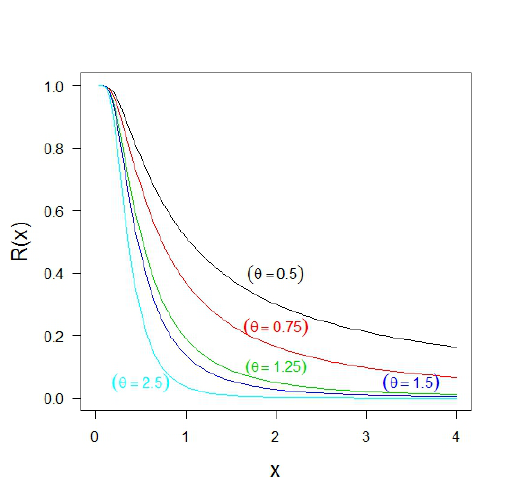
Figure 1 – Reliability function plot of IEGD for different values of θ .